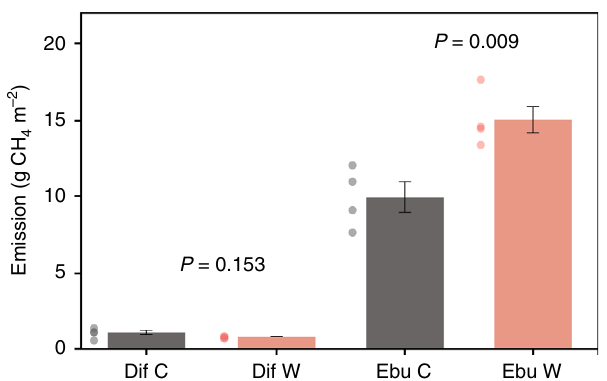
Fig. 2 Cumulative annual diffusive (Dif) and ebullitive (Ebu) CH 4 emission for the control (C) and warm (W) treatment of our mesocosm experiment. Error bars denote 1 s.e.m. ( n = 4). Differences between treatments were